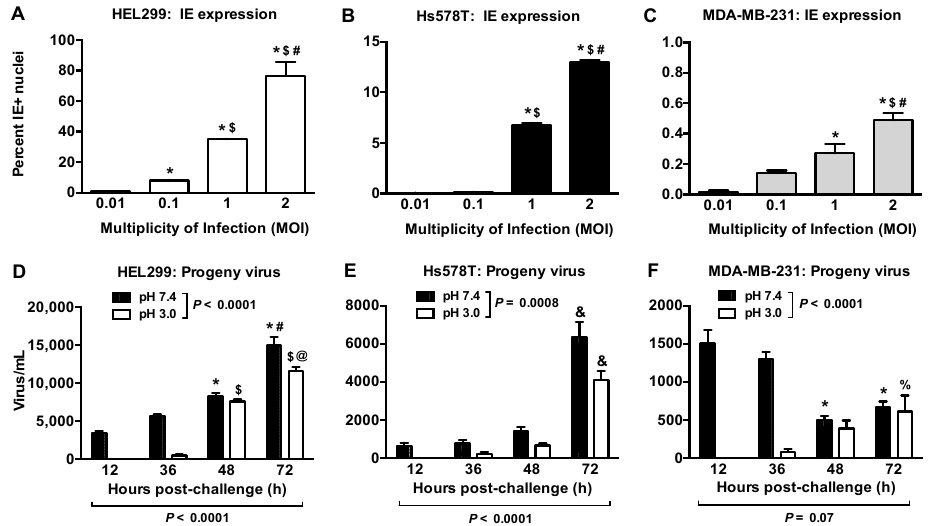
Figure 2. Immediate early (IE) antigen expression and production of progeny virus differed in HCMV ‐ challenged fibroblasts and breast cancer cells. A – C , HEL299 fibroblasts ( A ), Hs578T ( B ) and MDA ‐ MB ‐ 231 ( C ) breast cancer cells were exposed to different HCMV MOIs and cells positive for IE antigen were quantified 36 h later. Results are mean ± SEM from three independent experiments. P ‐ values were calculated by one ‐ way ANOVA with a Tukey’s post ‐ hoc test. *, P < 0.01 compared to 0.01 MOI; $, P < 0.01 compared to 0.1 MOI; #, P < 0.05 compared to 0.01 MOI; $, P < 0.01 compared to 0.1 MOI; #, P < 0.05 compared to 1 MOI. D ‐ F, Infectious virus was quantified from cell lysates after exposure to 0.1 MOI in HEL299 fibroblasts ( D ) or 2 MOI in breast cancer cells ( E , F ). Cells were washed 2 h after viral exposure with HEPES ‐ buffered saline at pH 7.4 or pH 3.0 followed by further culture in normal media until collection of cell lysates at the times indicated. Lysates were added to fresh uninfected HEL299 fibroblasts for 24 h and cells were stained for HCMV IE antigen denoting infectious virus in the lysates, with results expressed as virus/mL. Results are means ± SEM from three independent experiments with P ‐ values calculated by two ‐ way ANOVA and Tukey’s post hoc test. *, P < 0.05 compared to 12 and 36 h pH 7.4 wash; $, P < 0.0001 compared to 12 and 36 h pH 3.0 wash; #, P < 0.01 compared to 48 h pH 7.4 wash; @, P < 0.05 compared to 48 h pH 3.0 wash; &, P < 0.0001 compared to 12, 36, and 48 h washes; %, P < 0.05 compared to 12 h pH 3.0 wash.